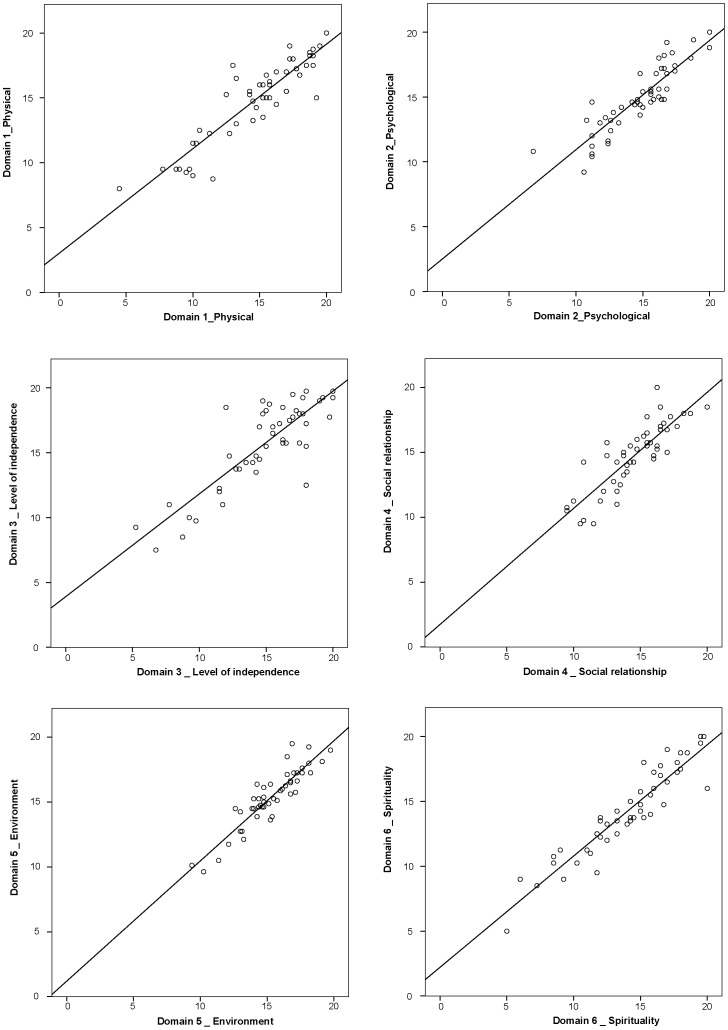
Relationship between scores of domains for test-retest WHOQOL-HIV.